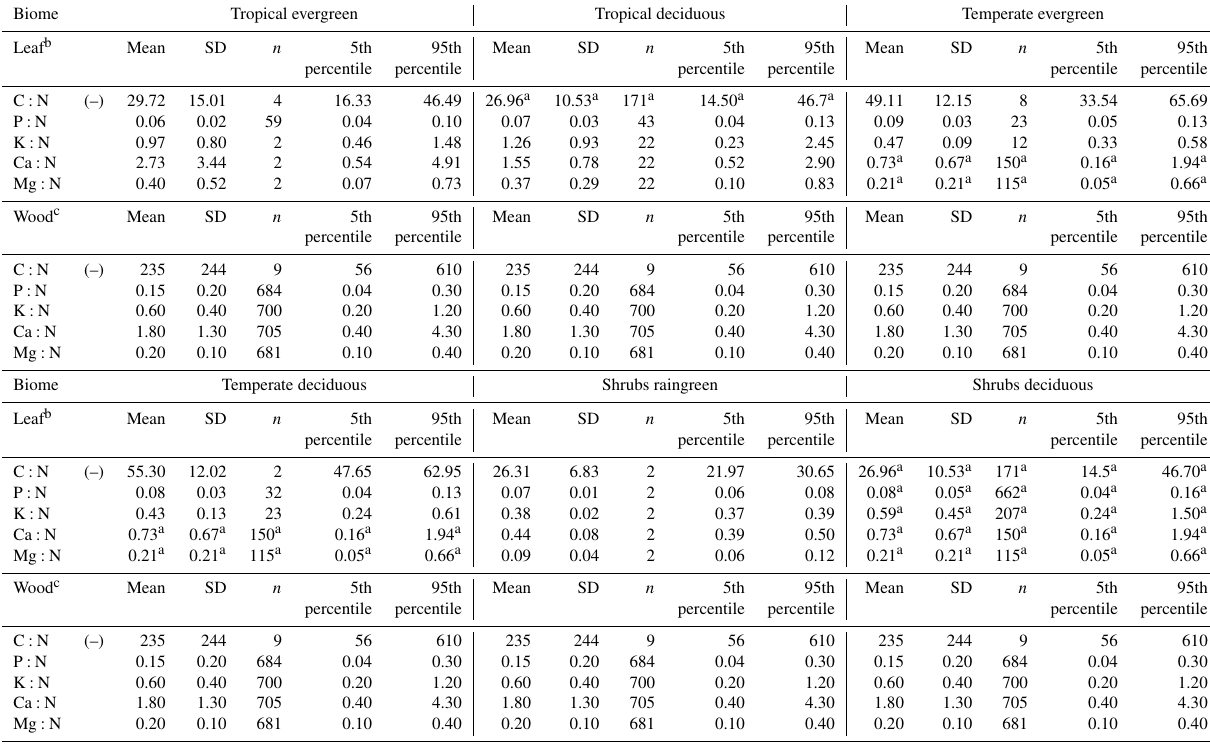
Table 1. Stoichiometric parameters for different pools and biomes used in this study.